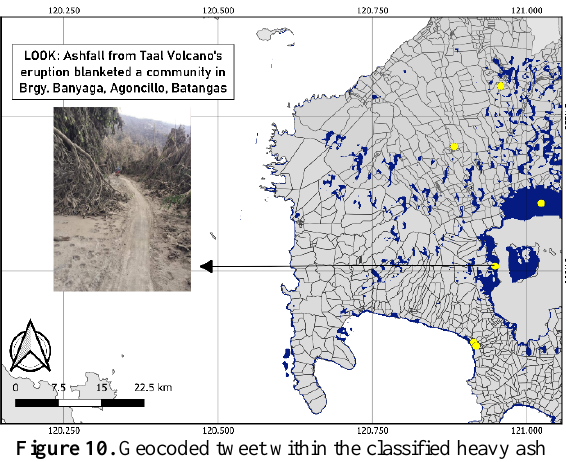
Figure 8. Geotagged tweet within the classified heavy ash reporting ashfall presence in Silang, Cavite